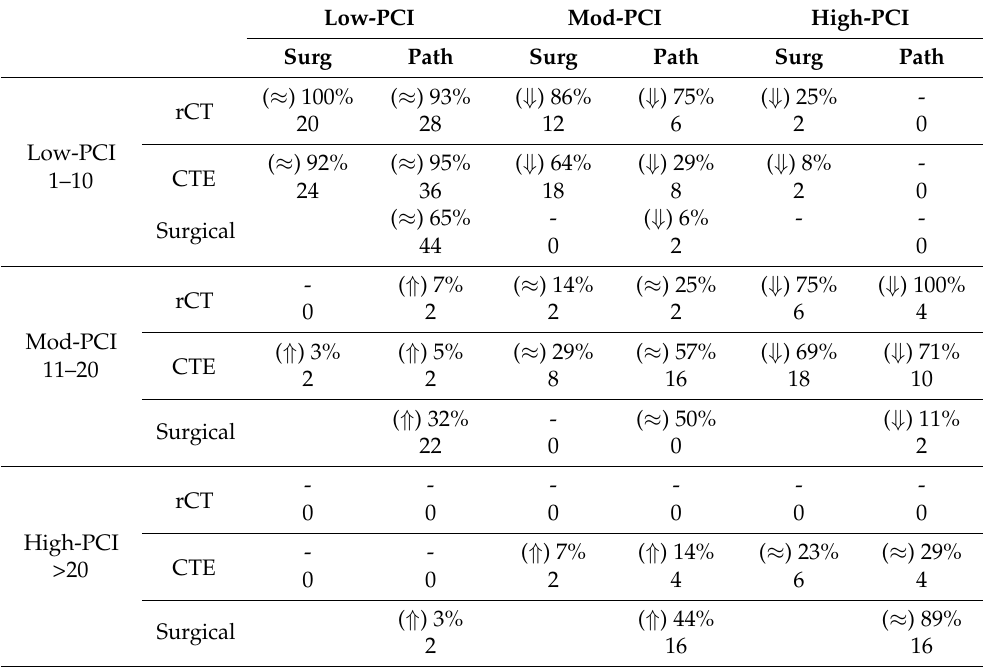
Table 5. Staging by tumor burden (Low-PCI, Mod-PCI, High-PCI). Concordance ( ≈ ), underestimation ( ⇓ ), overestimation ( ⇑ ) using two gold standards: surgical and pathological scoring.